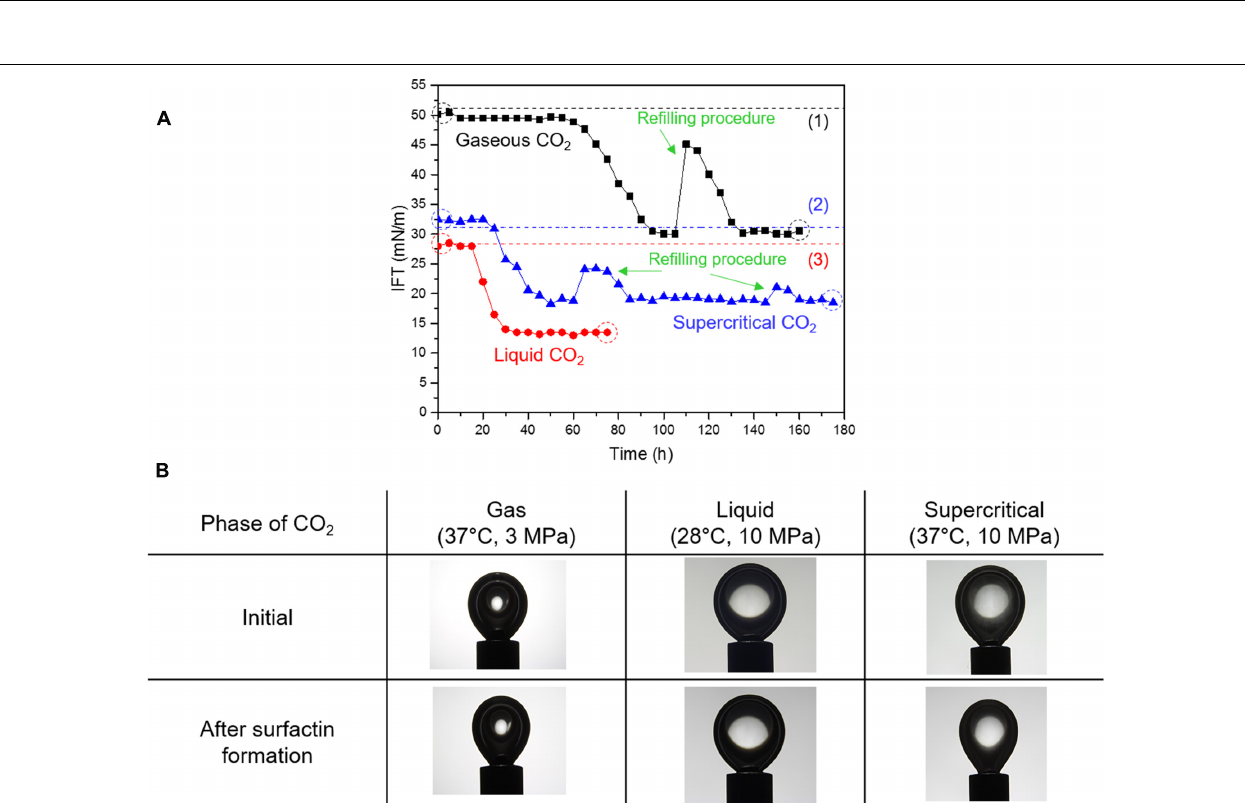
FIGURE 3 | (A) Variations in interfacial tension (IFT) of CO 2 -brine with the surfactin production, and (B) the digital images of pendant CO 2 droplets before and after the surfactin production. Note: The dotted lines indicate the IFT values from previous literature; IFT values for gaseous and supercritical CO 2 (1,2) are from Georgiadis et al. (2010) and the IFT value for liquid CO 2 (3) is from Hebach et al. (2002). The droplet images in panel B correspond to the dotted circles in panel A .